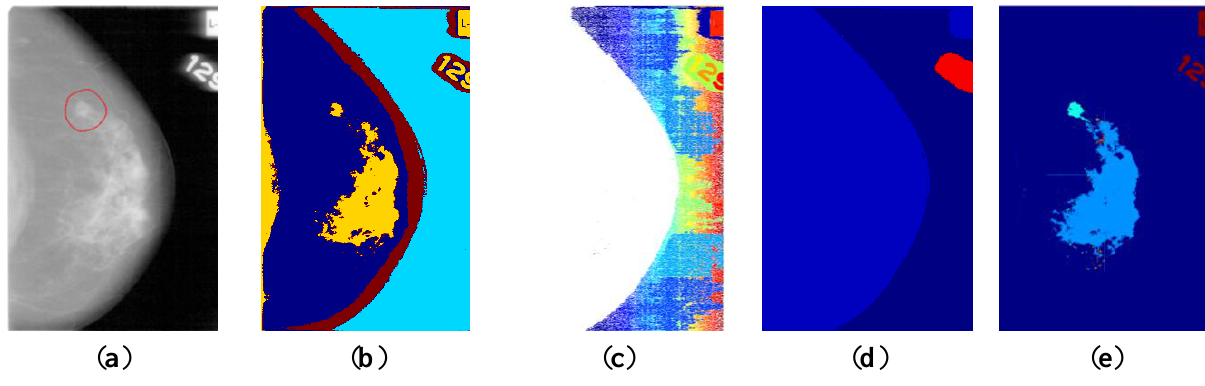
Figure 1. ( a ) Left craniocaudal view of a patient with a malignant mass, manually segmented by a domain expert (circled). Low-power salt and pepper acquisition noise, not visible at scale, corrupts the image; ( b ) k-means clustering ( k = 4) identifies regions of interest (ROIs), but loses part of the image border and does not distinguish between important and unimportant ROIs (e.g. the pectoral muscle, the lesion, and normal tissue all fall into the same cluster). Increasing k simply resulted in empty clusters; ( c ) Watershed segmentation of the gradient identifies the overall contour of the breast, but fails to identify any regions within and oversegments the noisy background; ( d ) WaveCluster with a low density threshold (15%) segments the entire breast, while ( e ) WaveCluster with a higher threshold (85%) isolates and highlights the suspicious